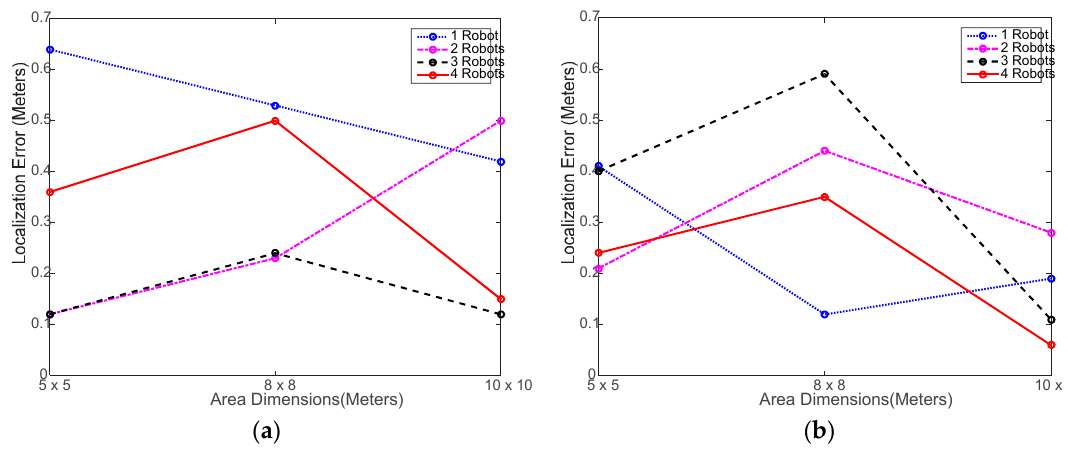
Figure 6. Localization error achieved in the experimental testing: ( a ) using distributed WiMAP algorithm; ( b ) using distributed DWiMAP.